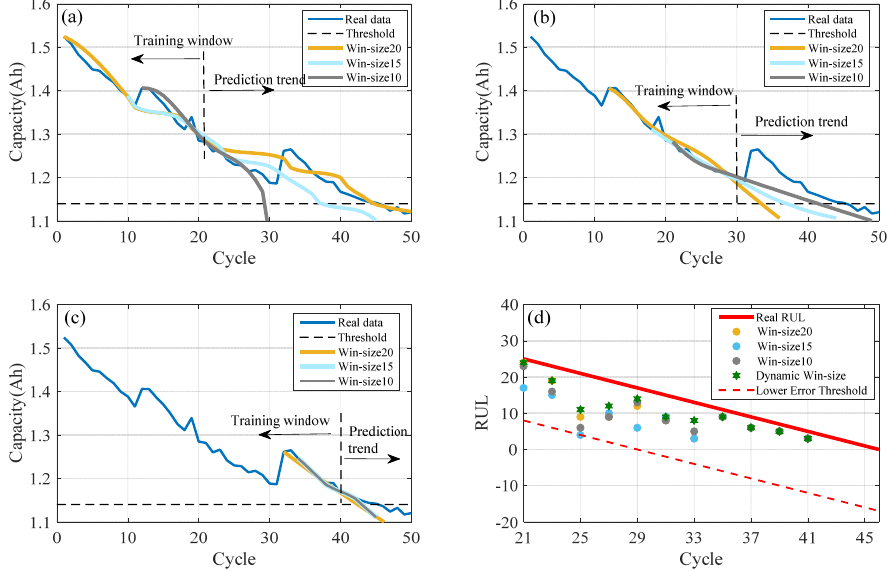
Figure 6. RUL prediction results of No. 47 with a dynamic window size: ( a ) prediction starting cycle of 21; ( b ) prediction starting cycle of 30; ( c ) prediction starting cycle of 40; ( d ) RUL prediction results. According to the quantity of each dataset, the compared fixed window sizes are se- lected differently. For instance, Figure 3 illustrates the RUL prediction results of No. 05